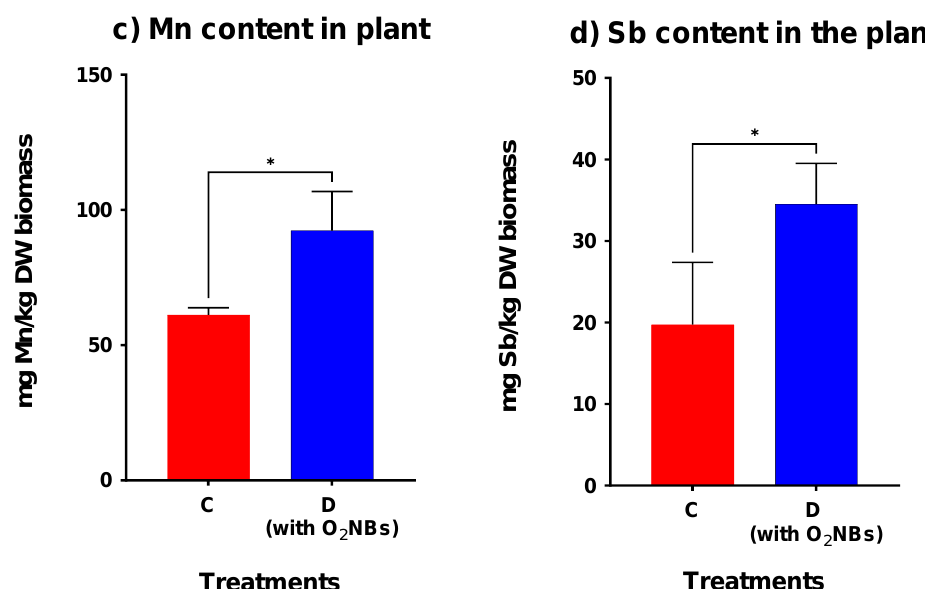
Figure 9. Comparison of total accumulation of ( a ) Fe, ( b ) Mg, ( c ) Mn and ( d ) Sb in plant tissues for treatments with and without O 2 NBs (Star indicates the level of significance: * for p < 0.05, ** for p < 0.01).